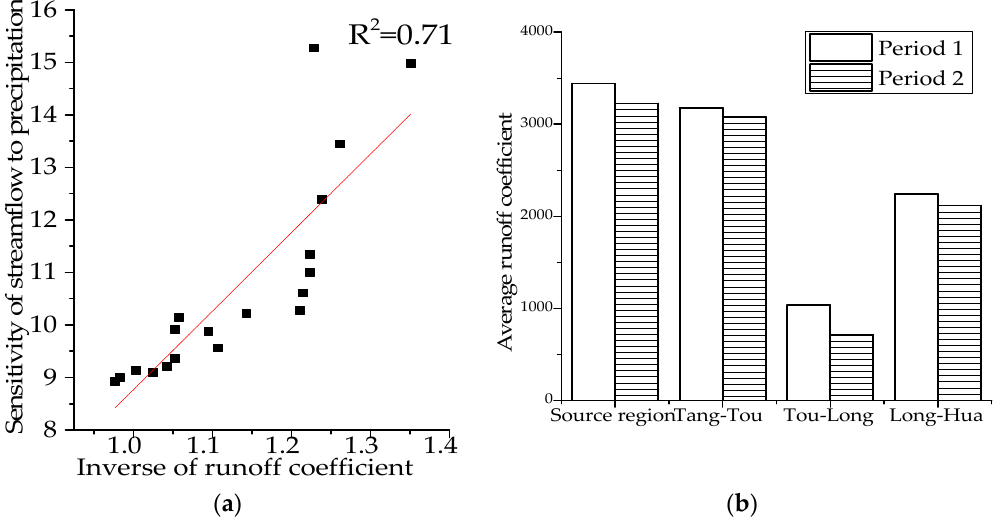
Figure 9. Correlation between sensitivity to precipitation and streamflow coefficient in the Tou-Long region ( a ) and the streamflow coefficients in different periods in four regions ( b ).